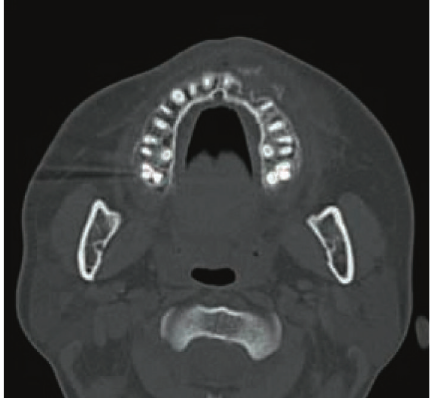
Figure 4: Axial CT showing fracture of alveolar bone in the lateral incisor and